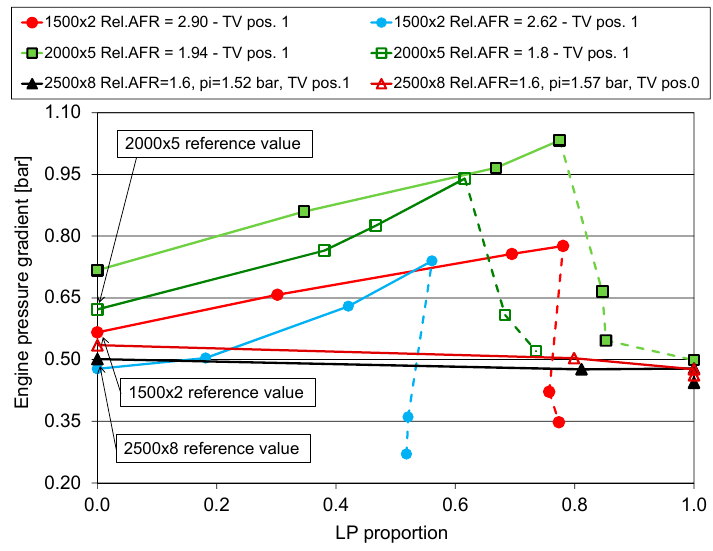
Figure 9. Engine pressure gradient as a function of LP proportion in different operating modes.